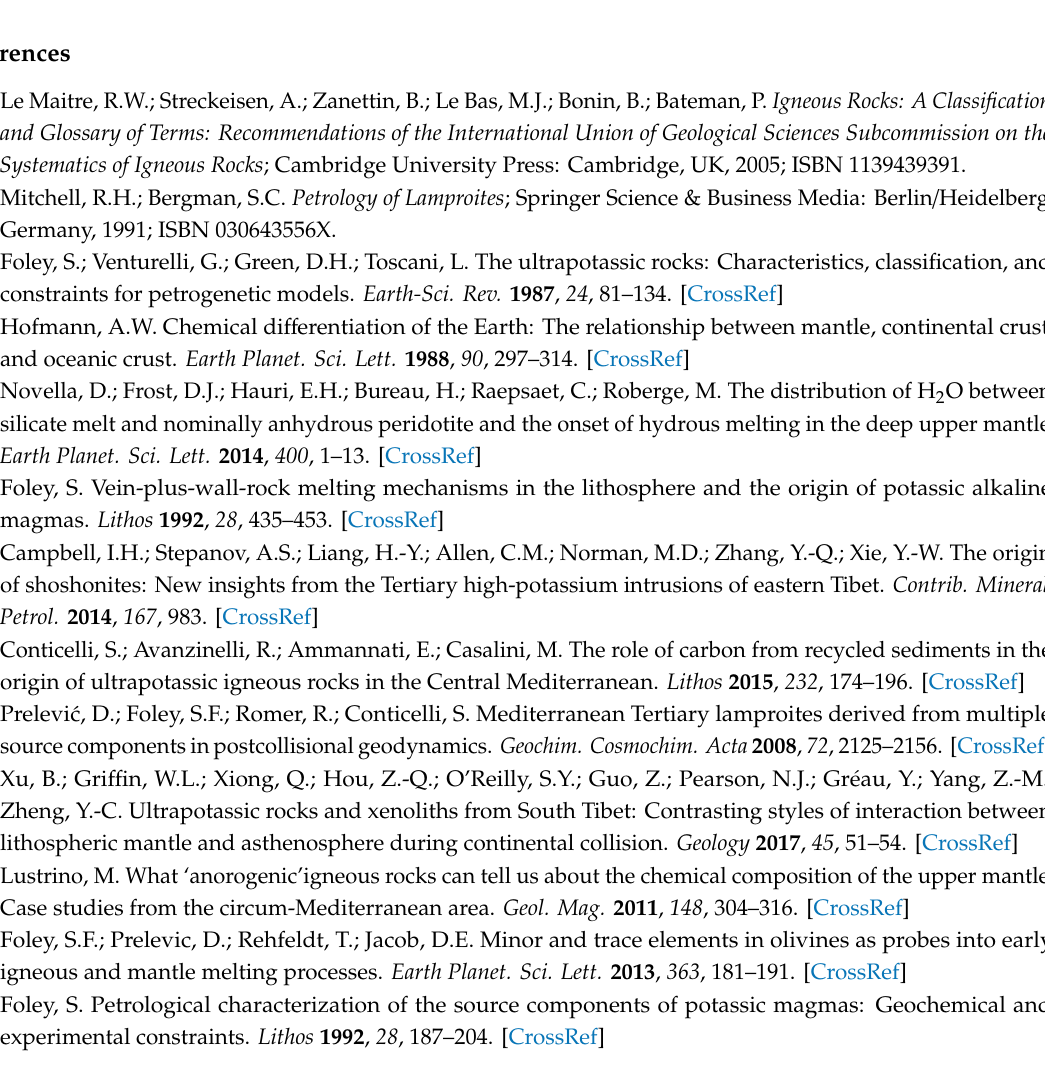
S2: Starting materials, Table S3: 3 GPa / 800 C Reaction Experiment. Table S4: 3 GPa / 850 C Reaction Experiment, Table S5: 3 GPa / 900 C Reaction Experiment, Table S6: 3 GPa / 1000 C Reaction Experiment. Table S7: 2nd-stage starting composition, Table S11: Reference materials for LA-ICP-MS quality control, Table S12: Solution ICP-MS measurements, Table S13: Trace elements of 3 GPa / 1000 C sediment-dunite reaction experiment, Table S14: Trace element